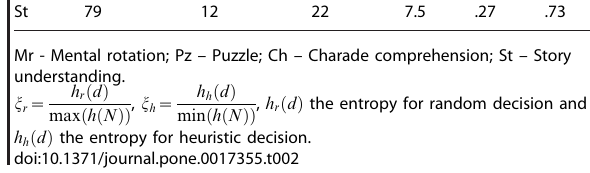
Mr - Mental rotation; Pz – Puzzle; Ch – Charade comprehension; St – Story understanding.